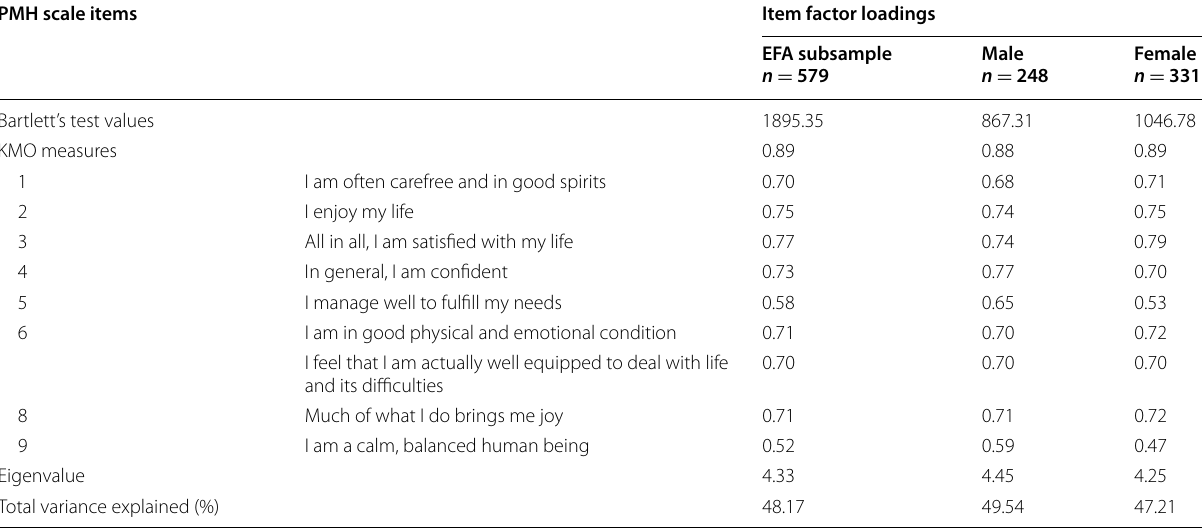
Table 3 Bartlett’s test values, Kaiser–Meyer–Olkin (KMO) measures, item factor loadings, eigenvalues, and total explained variance